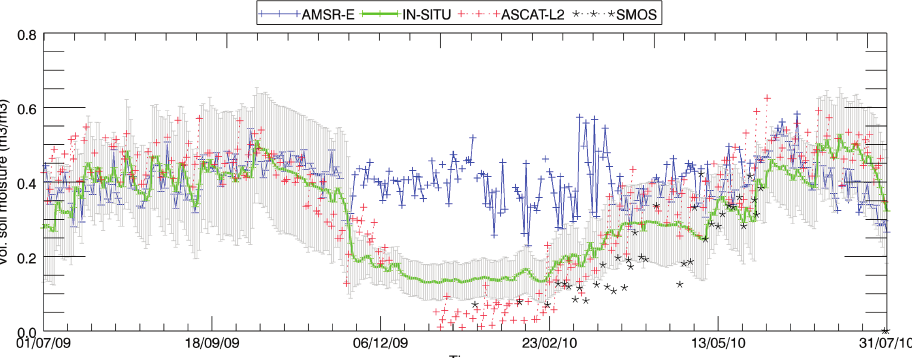
Fig. 7. The AMSR-E (+ in blue), ASCAT-L2 (+ in red) and SMOS soil moisture retrieval (* in black) for the Maqu area compared to soil moisture measured at 5cm soil depth in Maqu network area, showing the average (solid green line) and one standard deviation around the mean (error bars) from 1 July 2009 to 31 July 2010, using all 20 stations.